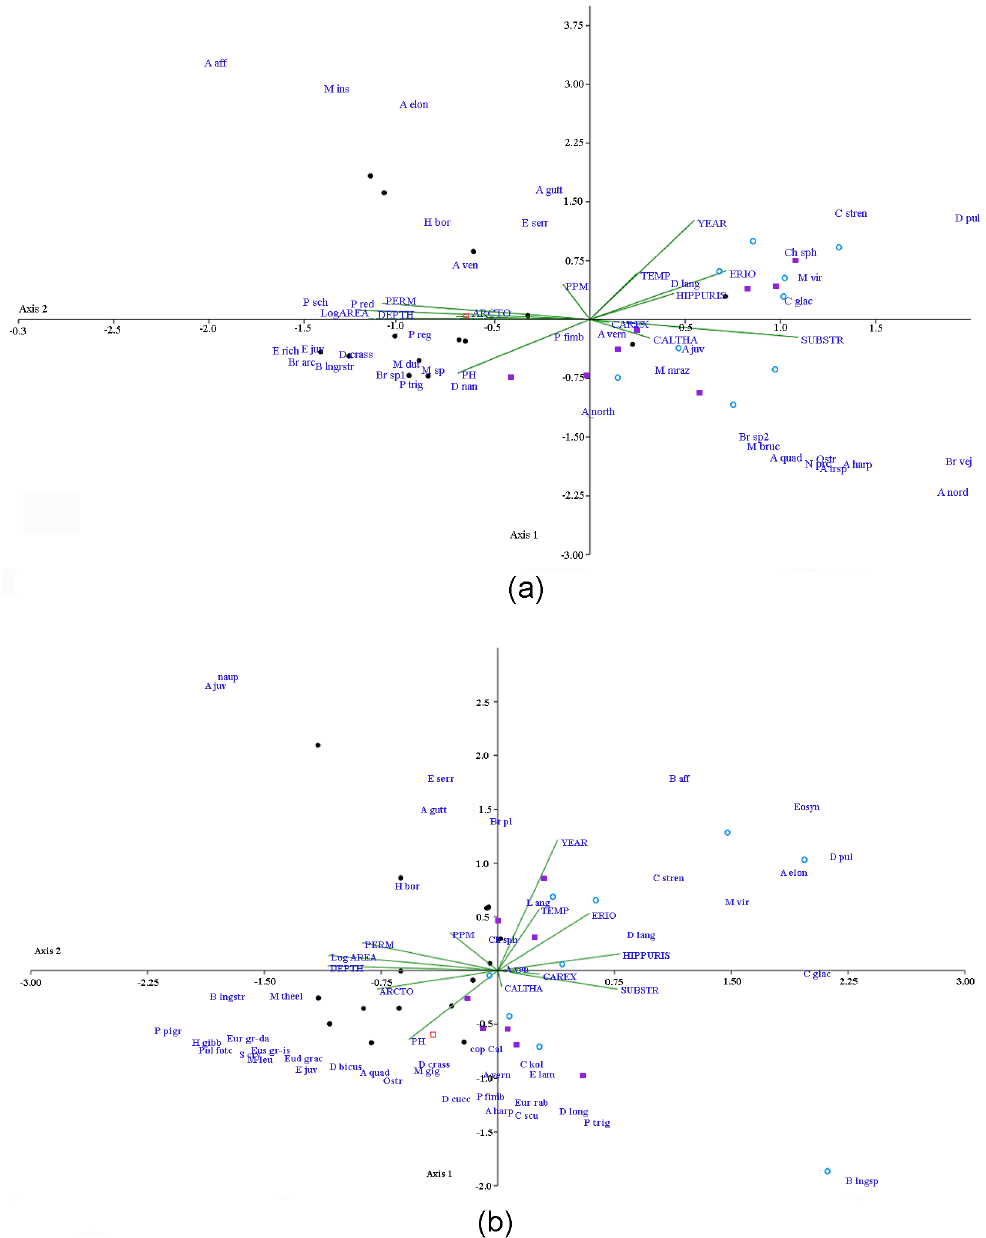
Figure 4. CCA ordination of benthic ( a ) and planktonic ( b ) crustaceans in the surveyed sites of the Lena Delta. Environmental variables included in both plots. Species are abbreviated as: A elon- Alo. elongatus ; A gutt- Al. guttata ; A harp- A. harpae ; A nord- At. nordenskioldii ; A den- At. dentata ; A juv-Aloninae juv; A quad- Al. quadrangularis ; A trsp- At . cf. trispinosa ; A ven- Ac. venustus ; A vern- Ac. vernalis ; B aff- Bi. affinis ; B lngsp- Bo . cf. longispina ; B lngrstr- Bo . longirostris ; Br arc- Br. arcticus ; Br pal- B. paludosa ; Br sp1- Br . sp. 1; Br sp2- Br . sp. 2; Br vej- Br. vejdovskyi ; C glac- Ca. glacialis ; Ch sph- Ch . cf. sphaericus ; C scu- C. scutifer ; C stren- C . cf. strenuus ; C kol- C. kolensis ; Cop Cal-copepodid Calanoida; D bicus- Di. bicuspidatus ; D crass- Di. crassicaudis ; D cuc- D. cucullata ; D lang- Di. languidoides ; D long- D . cf. longispina ; D nan- Di. nanus ; D pul- D . cf. pulex ; E lam- Eu. lamellatus ; E rich- Ep. richardi ; E ser- Euc. gr. serrulatus ; Eosyn- E. jakutana ; E juv- Eurycercus juv; Eud grac- Eud. graciloides ; Eur gr-da- Eur. gracilicauda ; Eur gr-is- Eur. gracilis ; Eur rab- Eur. cf. raboti ; H bor- He. borealis ; H gibb- H. gibberum ; L ang- L. angustilobius ; M bryc- Ma. brucei ; M dut- Mo. duthiei ; M gig- Me. gigas ; M ins- Mo. insularis ; M leu- Mes. leuckarti ; M mraz- Mo. mrazeki ; M sp-Mo. sp.; M theel- M. theeli ; M vir- Me. viridis ; N pro- N. procerus ; naup-nauplii Copepoda; Ostr-Ostracoda spp.; P fimb- Par. fimbriatus ; P pigr- Pa. pigra ; P sch- Pe. schmeili ; P red- Pe. reductus ; P reg- Pe . cf. reggiae; P trig- Pl . cf. trigonellus ; Pol forc- P. forcipata ; S cry- S. crystallina . Colored symbols are water bodies of different types: black dotsbig lakes, violet squarescomplex ponds, blue circlessmall ponds, red